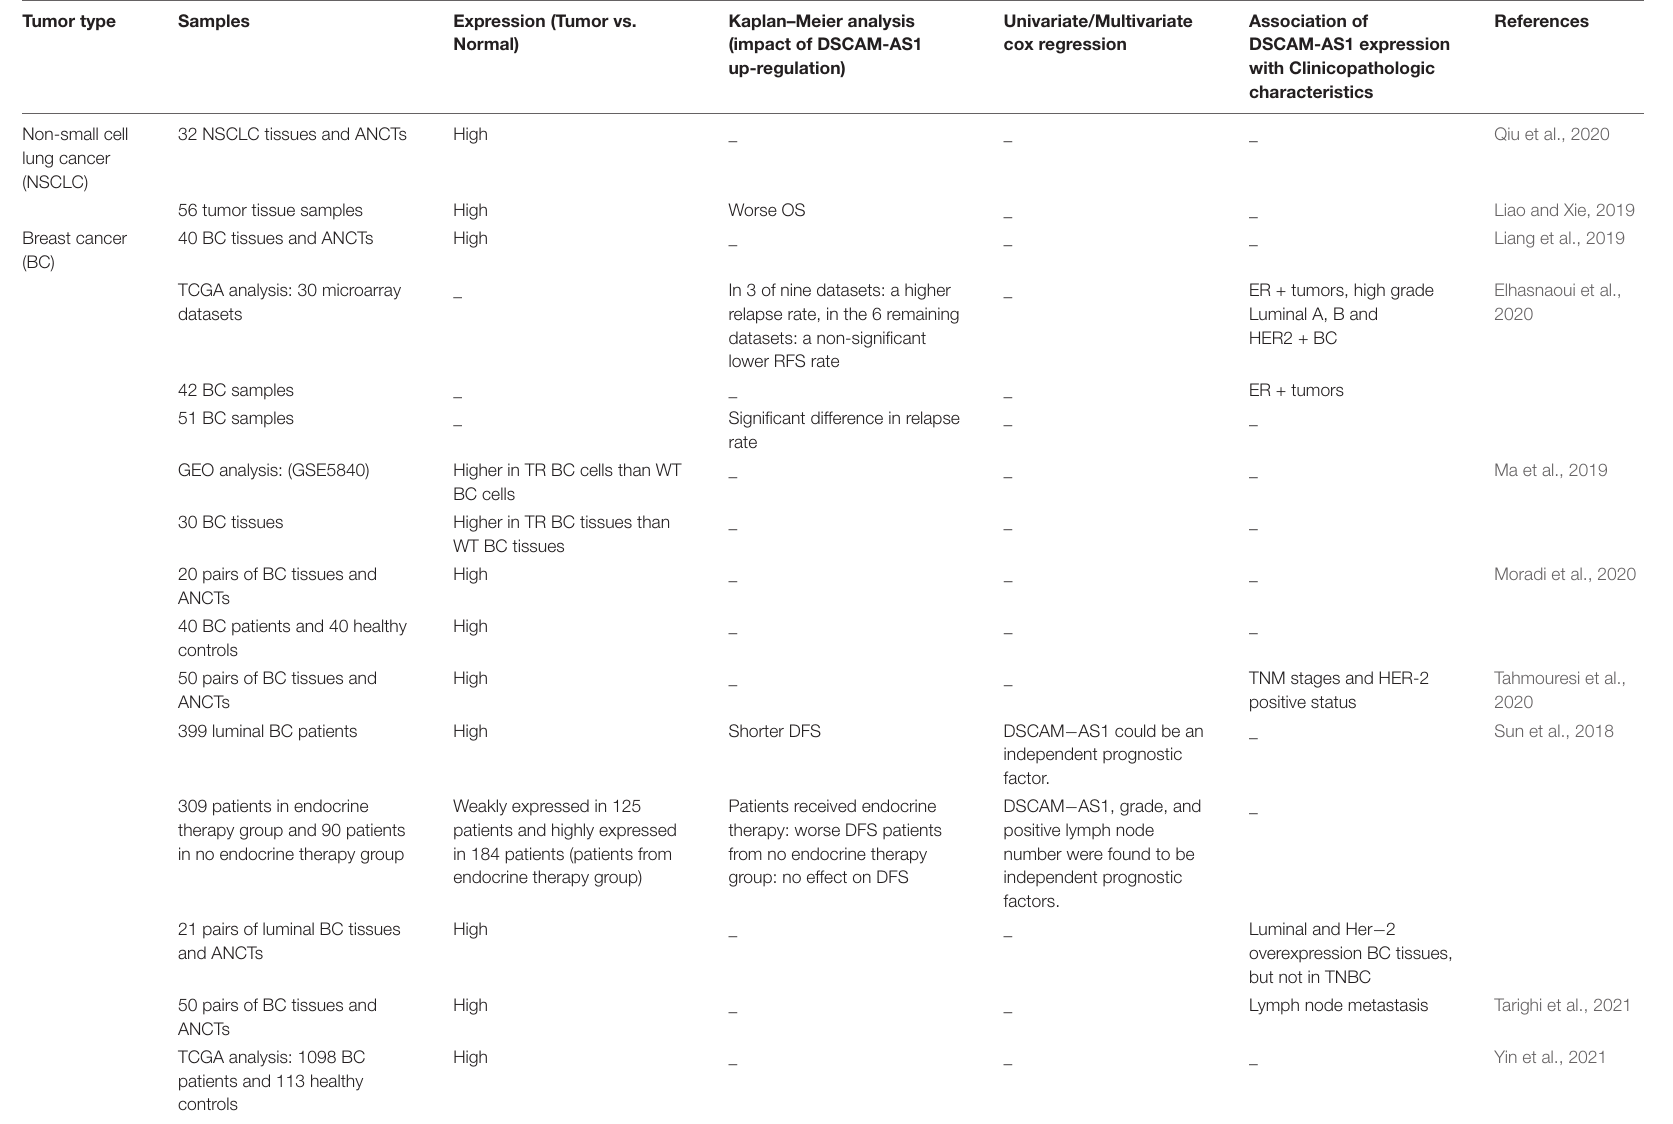
TABLE 3 | Results of papers that reported dysregulation of DSCAM-AS1 in clinical specimens (ANCTs, adjacent non-cancerous tissues; OS, Overall survival; DFS, Disease-free survival; TNM, tumor − node − metastasis; ER, Estrogen Receptor; TR, Tamoxifen − resistant; WT, wild type; TNBC, triple negative breast cancer; RFS, Relapse Free Survival). Tumor